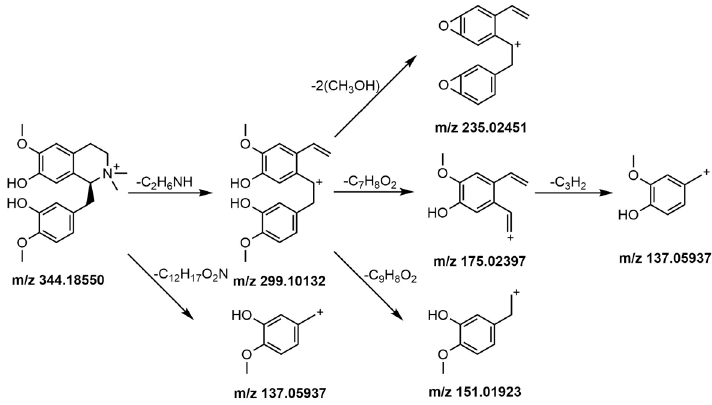
Figure 4. Mass spectrometric fragmentation processes of peak 3 tembetarine.